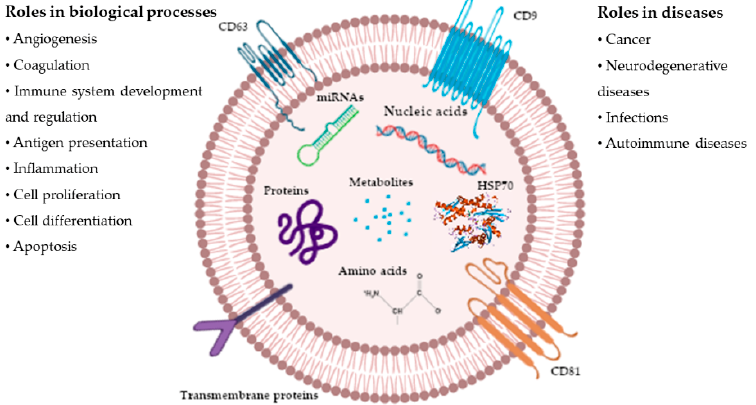
Figure 1. Simplified representation of the roles and contents of exosomes. Exosomes are extracellular nanovesicles generated by all cells, and they carry nucleic acids, proteins, lipids and metabolites. They are mediators of near- and long-distance intercellular communication in health and disease (modified from [1]).